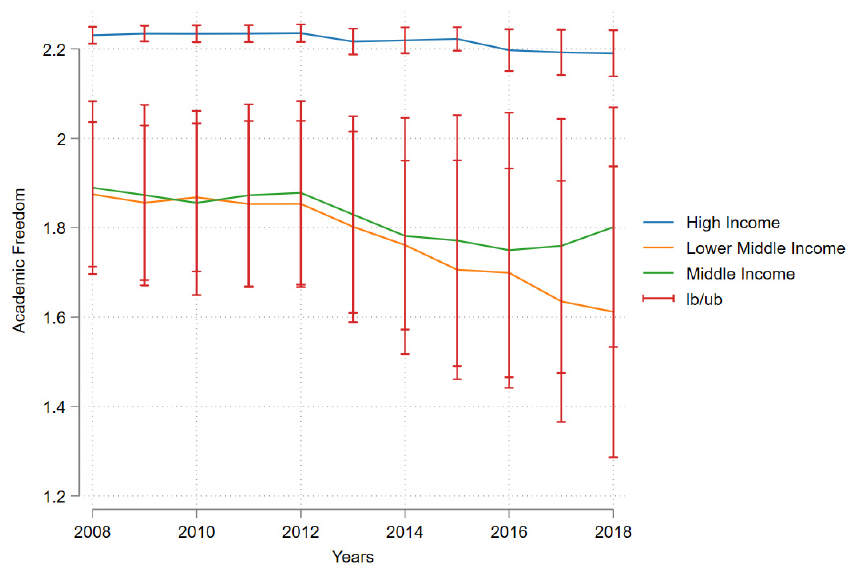
Figure 1. Trends in HDI by Income Level.